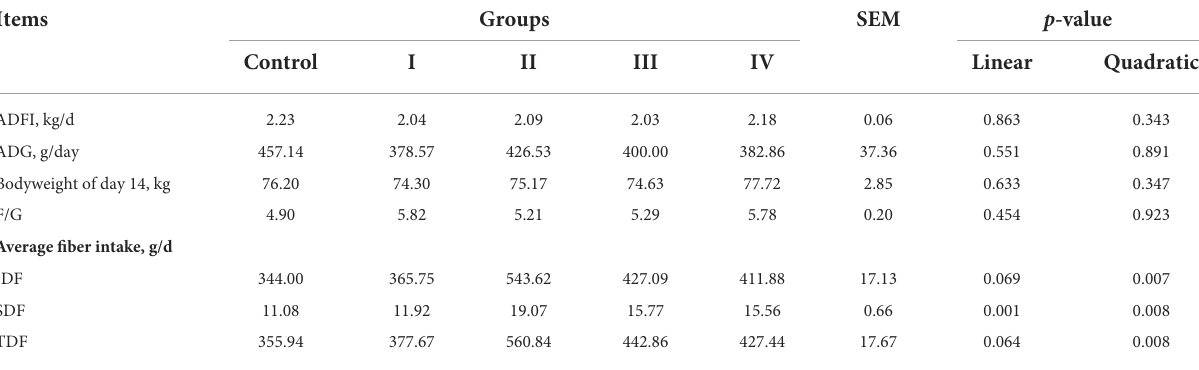
TABLE 1 The effects of short-term feeding of defatted rice bran-containing diets on growth performance in finishing pigs. Items Groups SEM p- value Control Linear